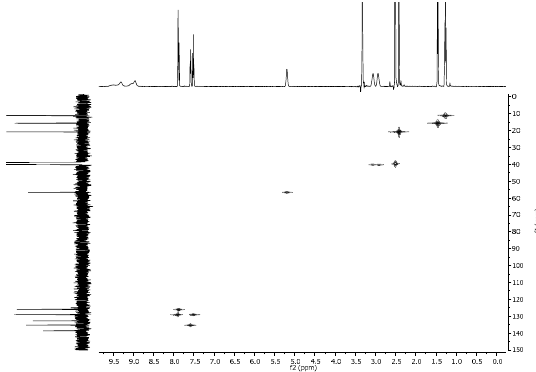
Figure 14. 1 H- 13 C HMQC spectrum of 3-MEC ( 4 ); 500MHz, DMSO-d 6 , RT.